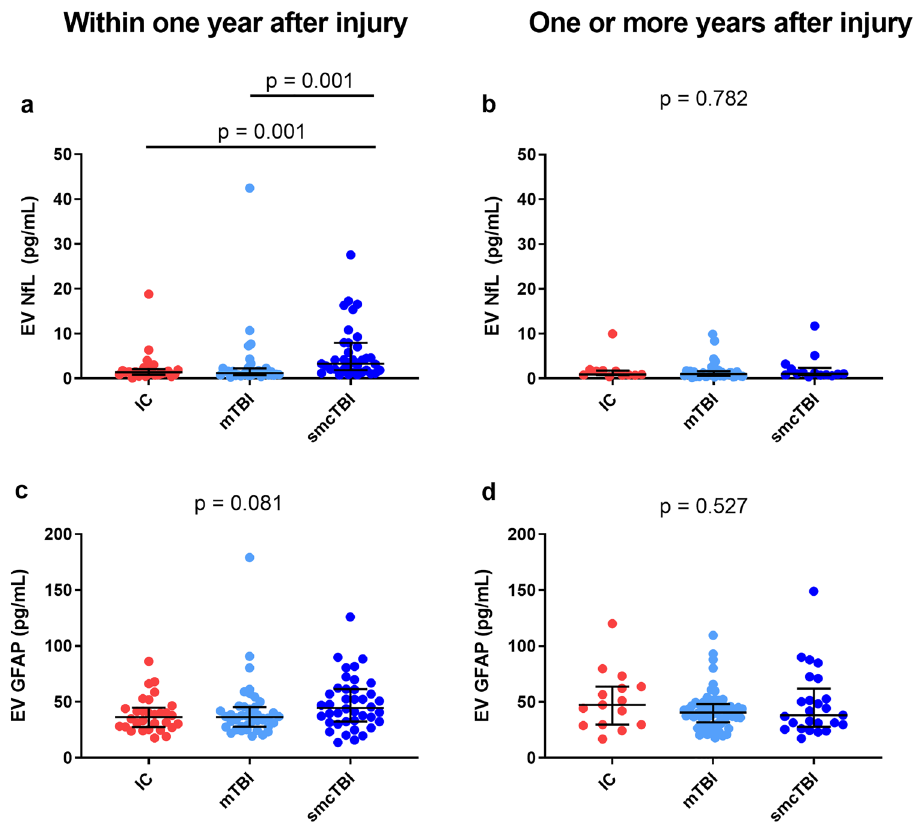
Figure 1. EV levels of biomarkers under one year ( a , c ) and one or more years after injury ( b , d ). Participants were divided into 3 groups at each timepoint: one or more years after injury (IC, n = 30; mTBI, n = 43; and smcTBI, n = 41) and one more years after injury (IC, n = 15; mTBI, n = 64; and smcTBI, n = 25). Biomarker concentrations are represented as median ± IQR. P values refer to non-parametric pairwise group comparisons adjusted for multiple comparisons (( a Dunn’s test correcting for repetitive pairwise comparisons using Bonferroni method) when overall group comparison was statistically significant, or overall group comparison significance ( b , c , d Kruskal–Wallis test). IC, injured controls; mTBI, uncomplicated mild TBI; smcTBI, complicated mTBI, moderate TBI, and severe TBI combined; TBI, traumatic brain injury; NfL, neurofilament light chain; GFAP, glial fibrillary acidic protein.